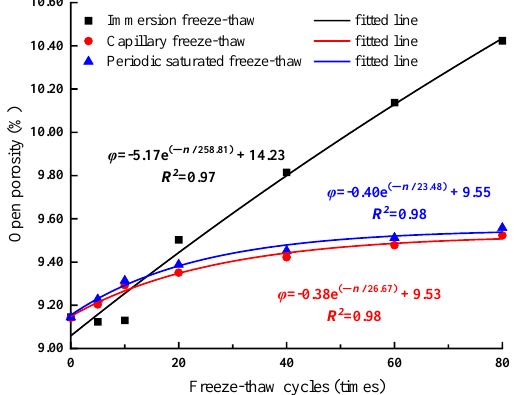
Figure 10. Open porosity changes in rock samples.